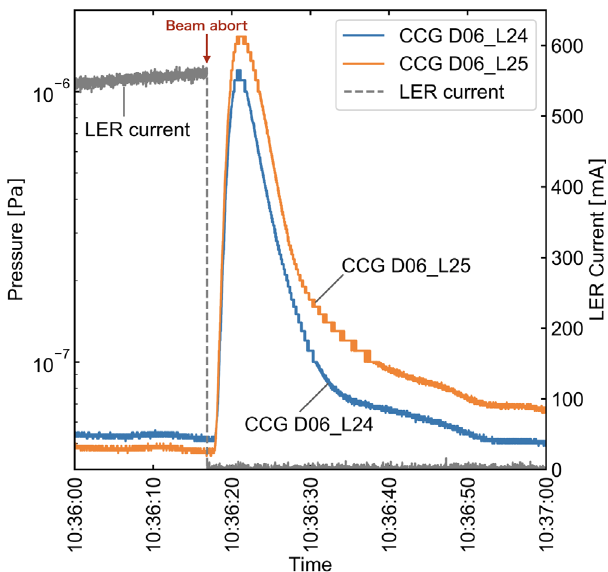
FIG. 17. Pressure burst in CCGs beside the D06V2 collimator and beam current in the LER.